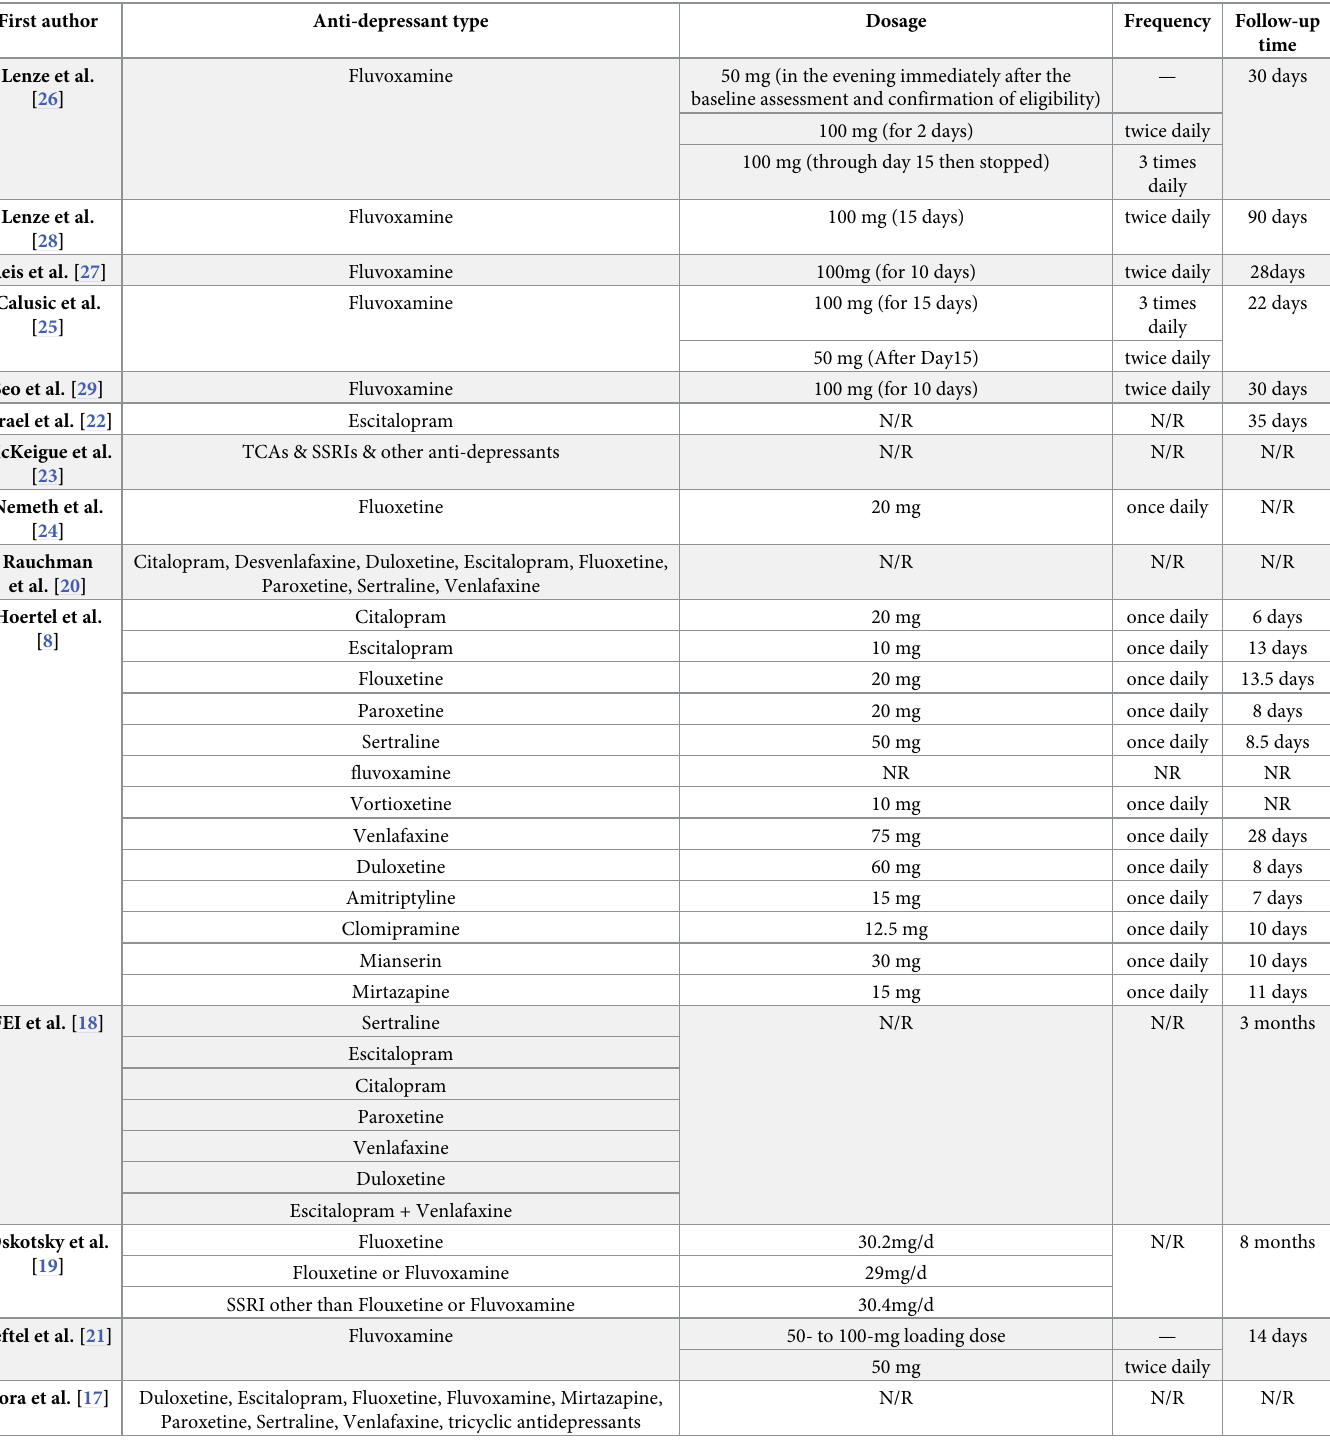
Table 6. Interventions and exposures